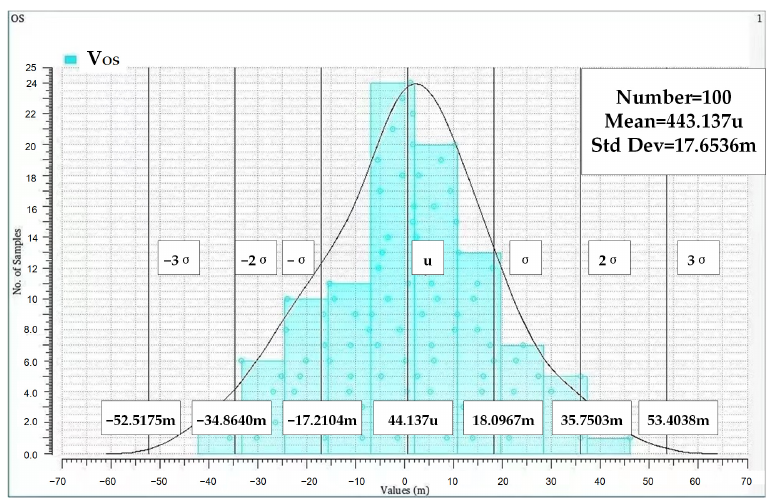
Figure 10. Monte Carlo simulation of the comparator, showing the offset voltage of comparator .